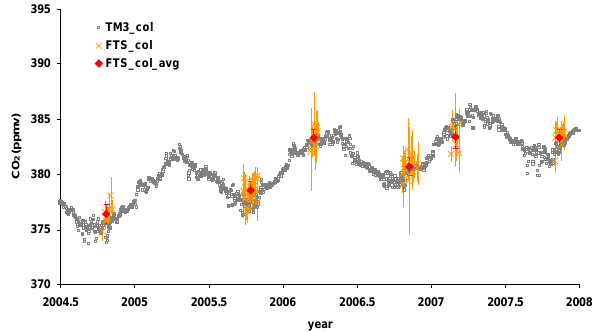
Figure 3 Fig. 3. Comparison of modeled and measured column averaged vmrs of CO 2 . Daily averages (FTS col) and averages for the mea- surement campaigns (FTS col avg) of column averaged vmrs of CO 2 have been calculated by scaling the column ratio CO 2 /O 2 by the vmr of O 2 and a factor 1.018. The TM3 model simulations (TM3 col) have a grid size of 3.8 ◦ × 5 ◦ and the center coordinate is 5.81 ◦ N 55.21 ◦ W. For XCO 2 the difference between the ocean grid cell used for the in situ comparison and the grid cell containing Paramaribo is small and therefore it is not relevant, which model grid is used for the XCO 2